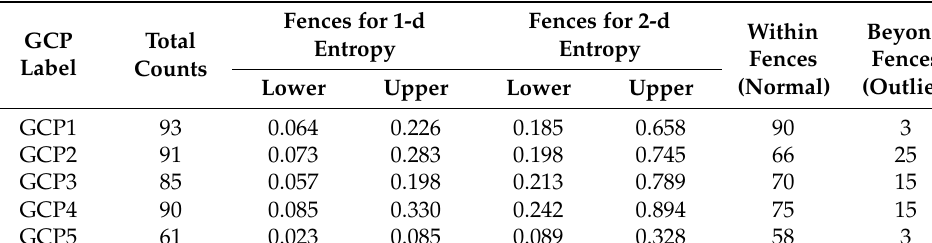
Figure 8. The 1-d and 2-d entropy value distribution for the five GCPs: ( a ) GCP1; ( b ) GCP2; ( c ) GCP3; ( d ) GCP4; ( e ) GCP5. The left column in each subfigure represents 1-d entropy, and the right Table 3. The classification result by the adjusted boxplot for the five GCPs. column represents 2-d entropy; the surroundings of the five GCPs are shown at the mid-upper side in each subfigure, respectively.